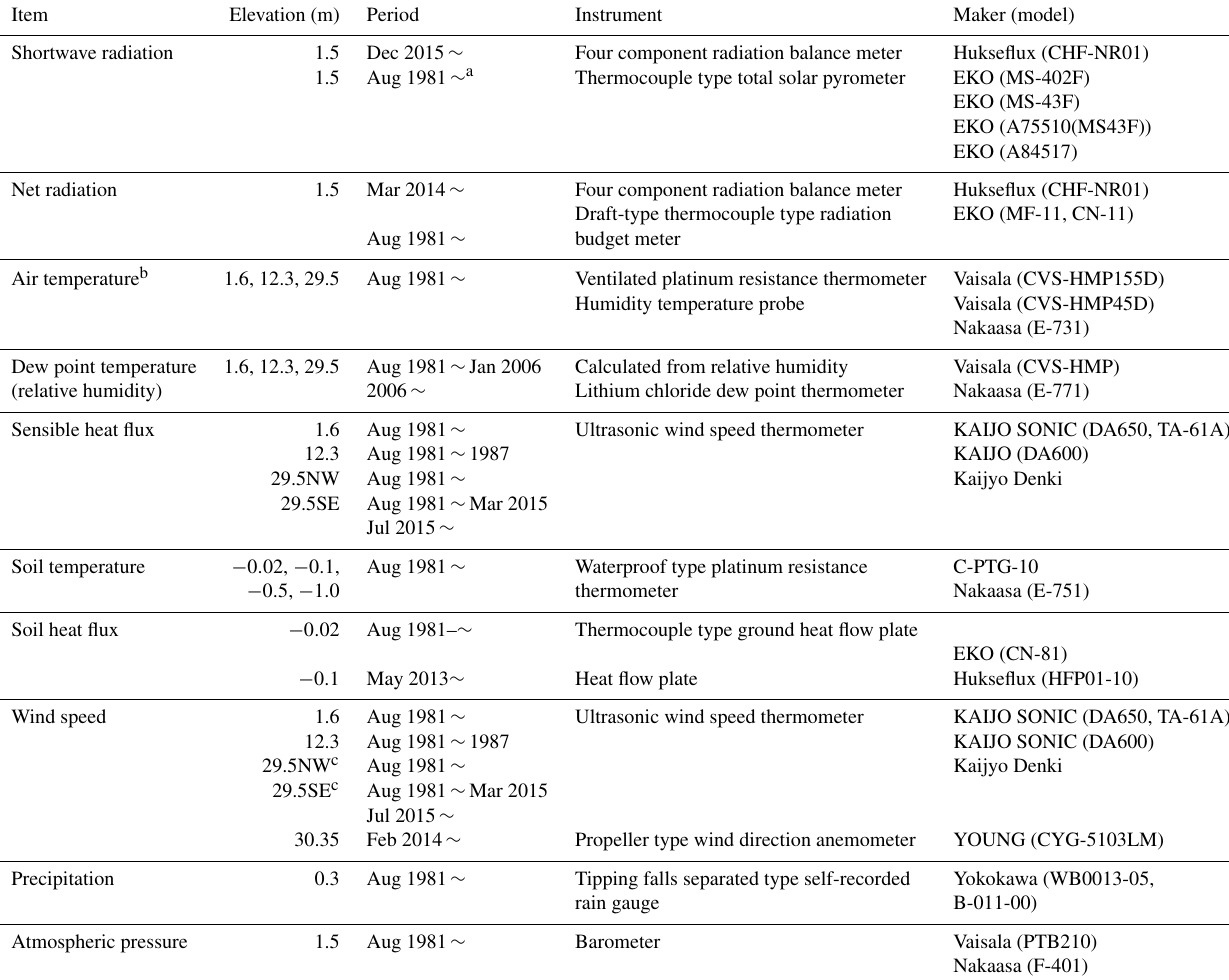
Table 1. Instrumentation information of the EDP observational